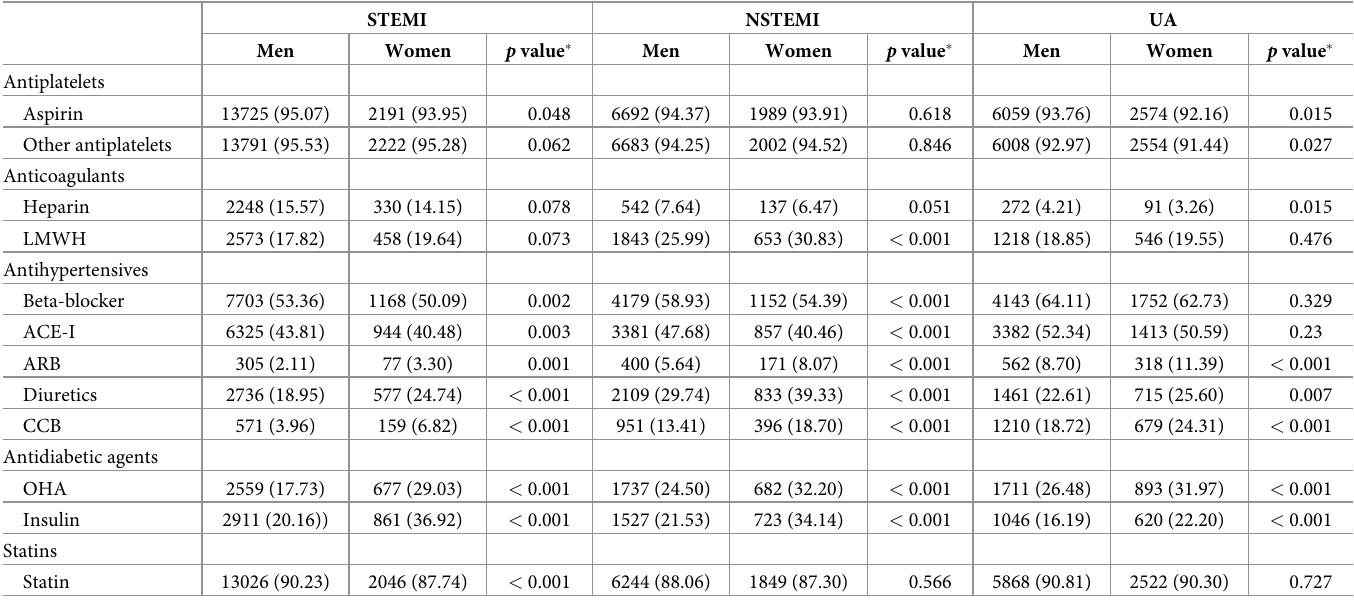
Table 2. In-hospital medications,